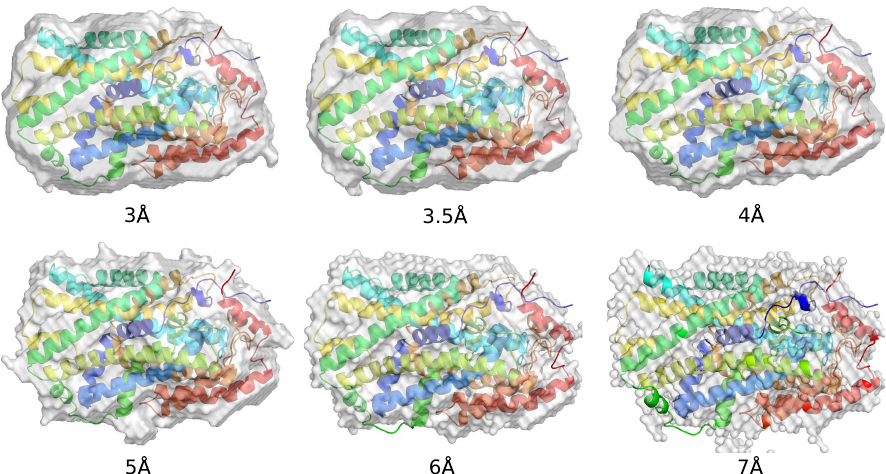
Figure 6. The calculated protein boundaries of 2JLN using the 3, 3.5, 4, 5, 6, and 7 Å observed data. The PDB deposited model is displayed as cartoons.